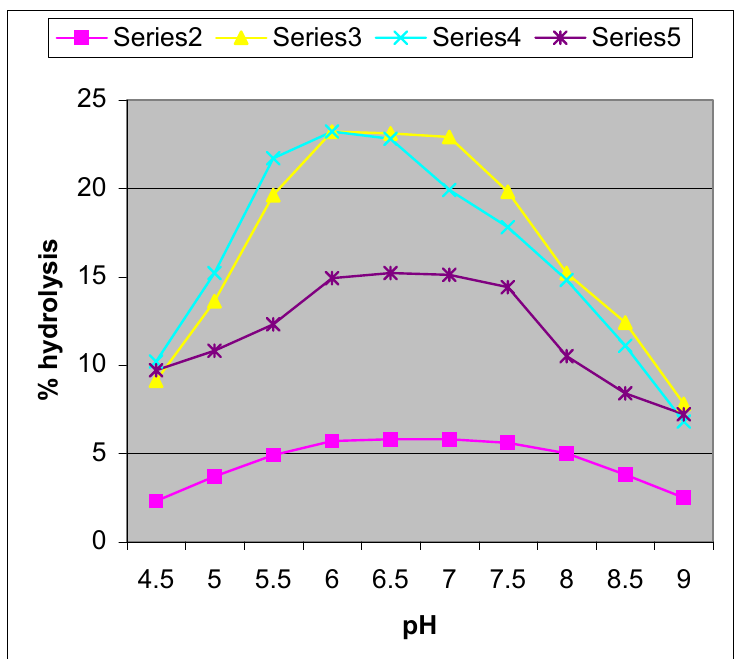
Figure1. pH-rate profile for [CoN [series5] ) and Turnbull’s blue[series4] promoted hydrolysis of NPP in aqueous media at 25 0 C, c = 5 x 10 -4 M, I = 0.1M NaClO